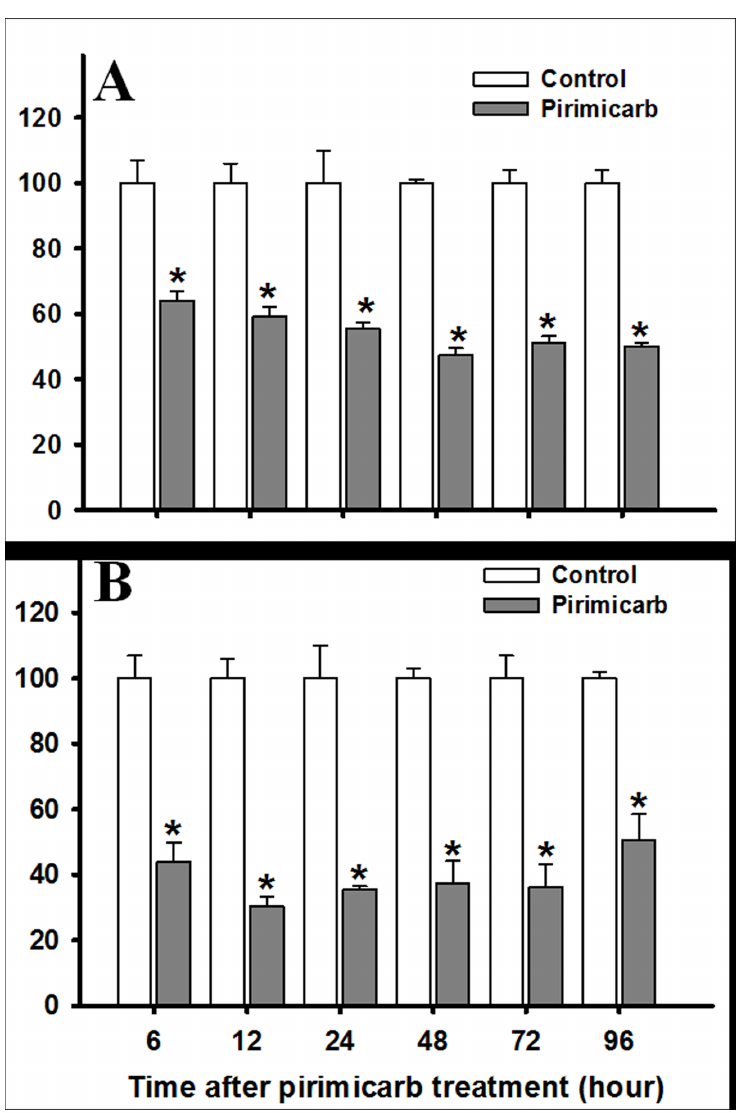
Fig 2. Effects of LC 25 of pirimicarb on AChE activities of R . padi (A) and S . avenae (B) from the parent generation. AChE activities were expressed as nmol of ATCh hydroplyzed/min/mg protein. The results are presented as the mean and standard errors of three replicates. Asterisk on the bars of the histogram indicate significant differences between treatment and respective control (t-test) at P < 0.05.